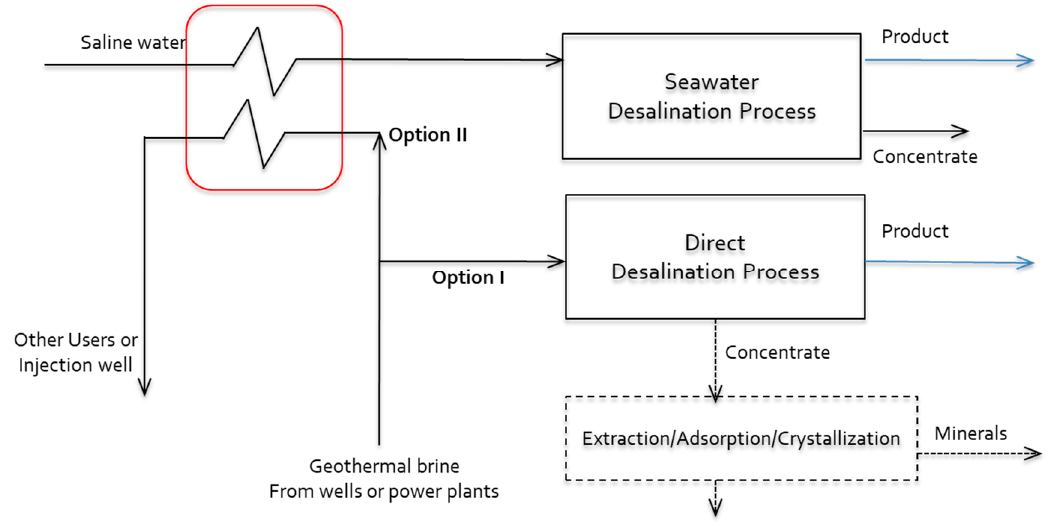
Figure 9. Simplified block diagram of the geothermal desalination options.